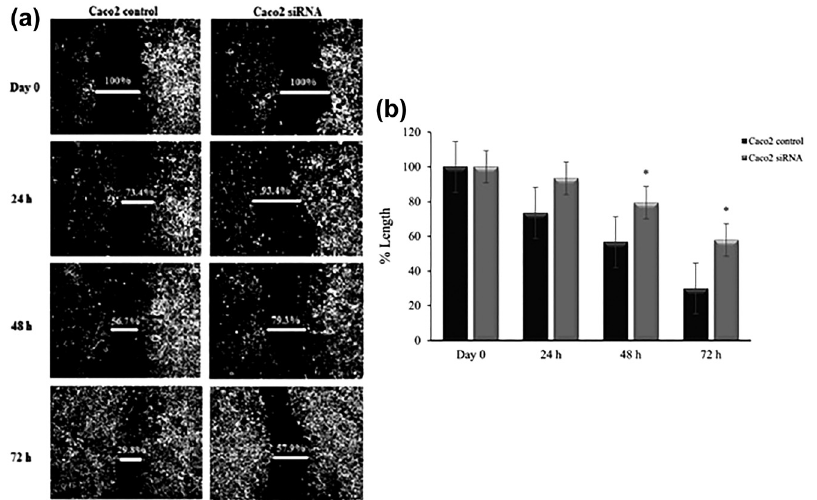
Figure 6: The migration of clusterin-silenced Caco2. (A)The migrationrate innon-clusterin-silenced(control)andclusterin-silencedCaco2(siRNA)at 24,48,and72hof incubation.Cellmigration was estimated by measuring the wound region of the culture. (B) The graph of statistical analysis of non-clusterin-silenced (control) and clusterin-silenced SW480 (siRNA) at 24, 48, and 72 h of incubation. The data are expressed as the mean ± SD (n = 3); *p<0.05.